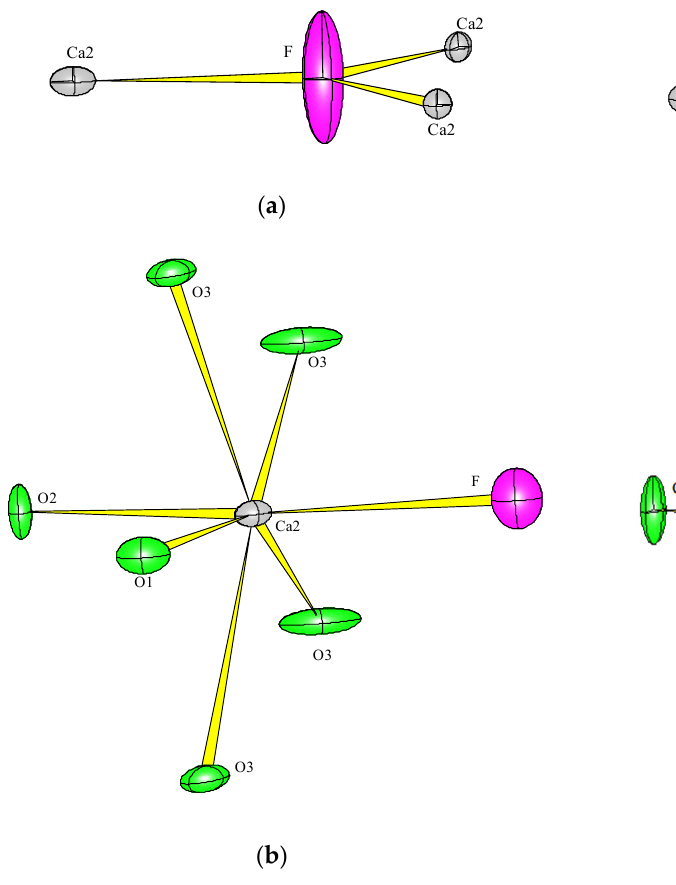
Figure 11. Small anisotropic displacement parameters for the F atom in sample-3 ( a , b ) compared to much larger parameters in sample-27 ( c , d ), which contains possible positional disorder of the F atom, or disorder of the F and OH as their positions are close to each other; ( a , c ) are for the 3-coordinated F site and ( b , d ) are for the 7-coordinated Ca2 site.